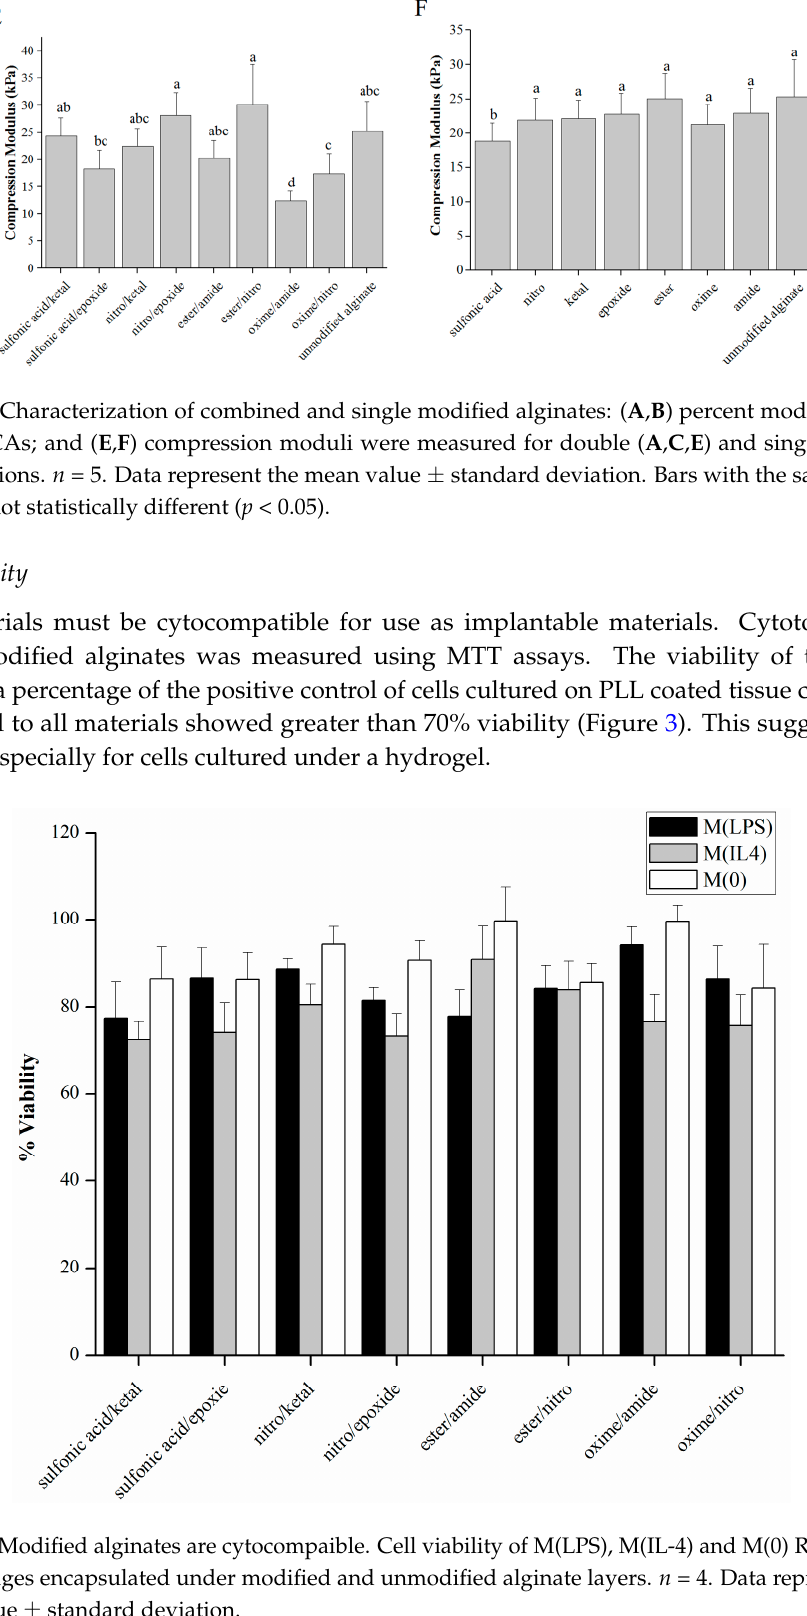
Figure 3. Modified alginates are cytocompaible. Cell viability of M(LPS), M(IL-4) and M(0) RAW 264.7 macrophages encapsulated under modified and unmodified alginate layers. n = 4. Data represent the mean value ± standard deviation.